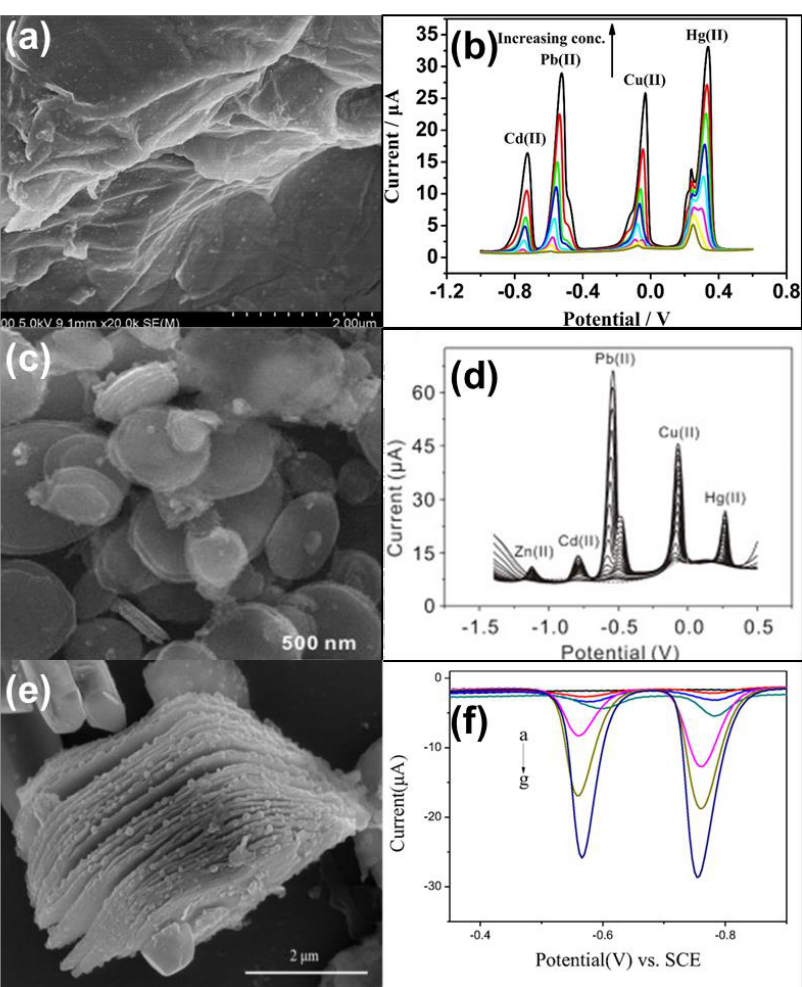
Figure 3. ( a ) FESEM image; ( b ) DPASV of graphene/CeO 2 hybrid nanocomposite for detection of Cd, Pb, Cu, and Hg ions with saturated Hg/Hg 2 Cl 2 as the reference electrode [38]; ( c ) SEM image of nanoplate stacked Fe 3 O 4 ; ( d ) SWASV of Fe 3 O 4 /GCE for detection of Zn, Cd, Pb, Cu, and Hg ions with Ag/AgCl/KCl (3 M KCl saturated with AgCl) as the reference electrode [22]; ( e ) SEM image; and ( f ) SWASV response of BiNPs@Ti 3 C 2 T X for detection of Pb and Cd ions [43].